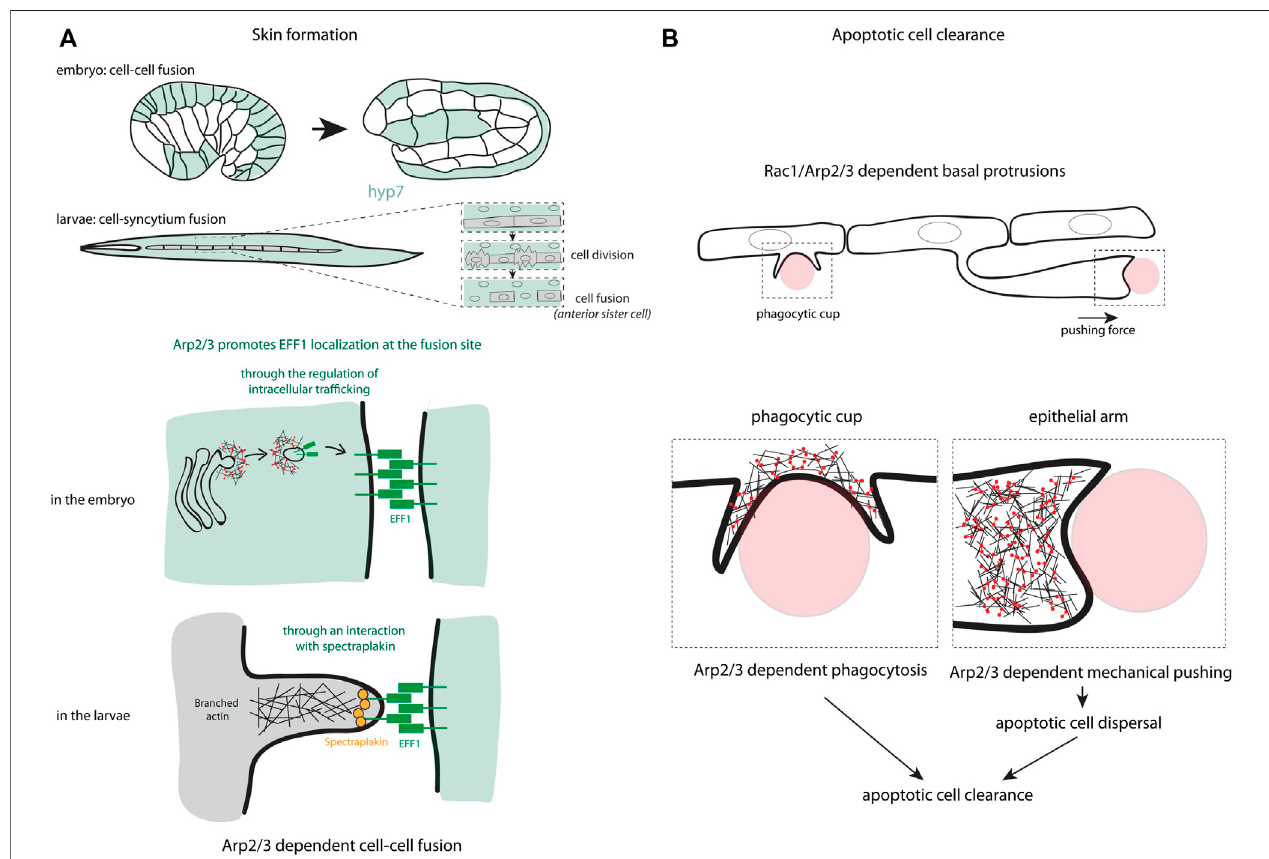
FIGURE 1 | Arp2/3 functions in cell-cell cooperation. (A) The different steps in the process of skin formation through cell-cell fusion in C . elegans are presented. These schemes highlight the different ways used by the Arp2/3 complex to localize the fusogen EFF-1 at the fusion site, either through the regulation of intracellular traf fi cking in the embryo or through an interaction of EFF-1 with spectraplakin in larvae. (B) Two mechanisms controlled by Arp2/3 used in epithelial sheet to eliminate apoptoticcells areschematizedincluding theformationofphagocytic cup and theformationofan epithelial arm pushing theapoptotic cellstodispersethemin the tissue and favor their rapid